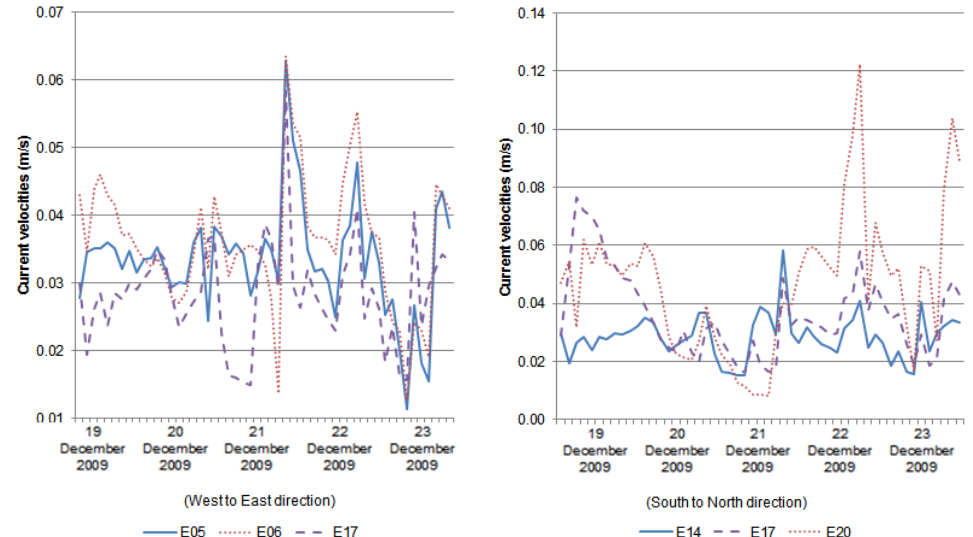
Figure 6. Time series of current speeds at stations E05, E06, and E17 ( left ) and stations E14, E17, and E20 ( right ) from 19 December 2009 to 23 December 2009.